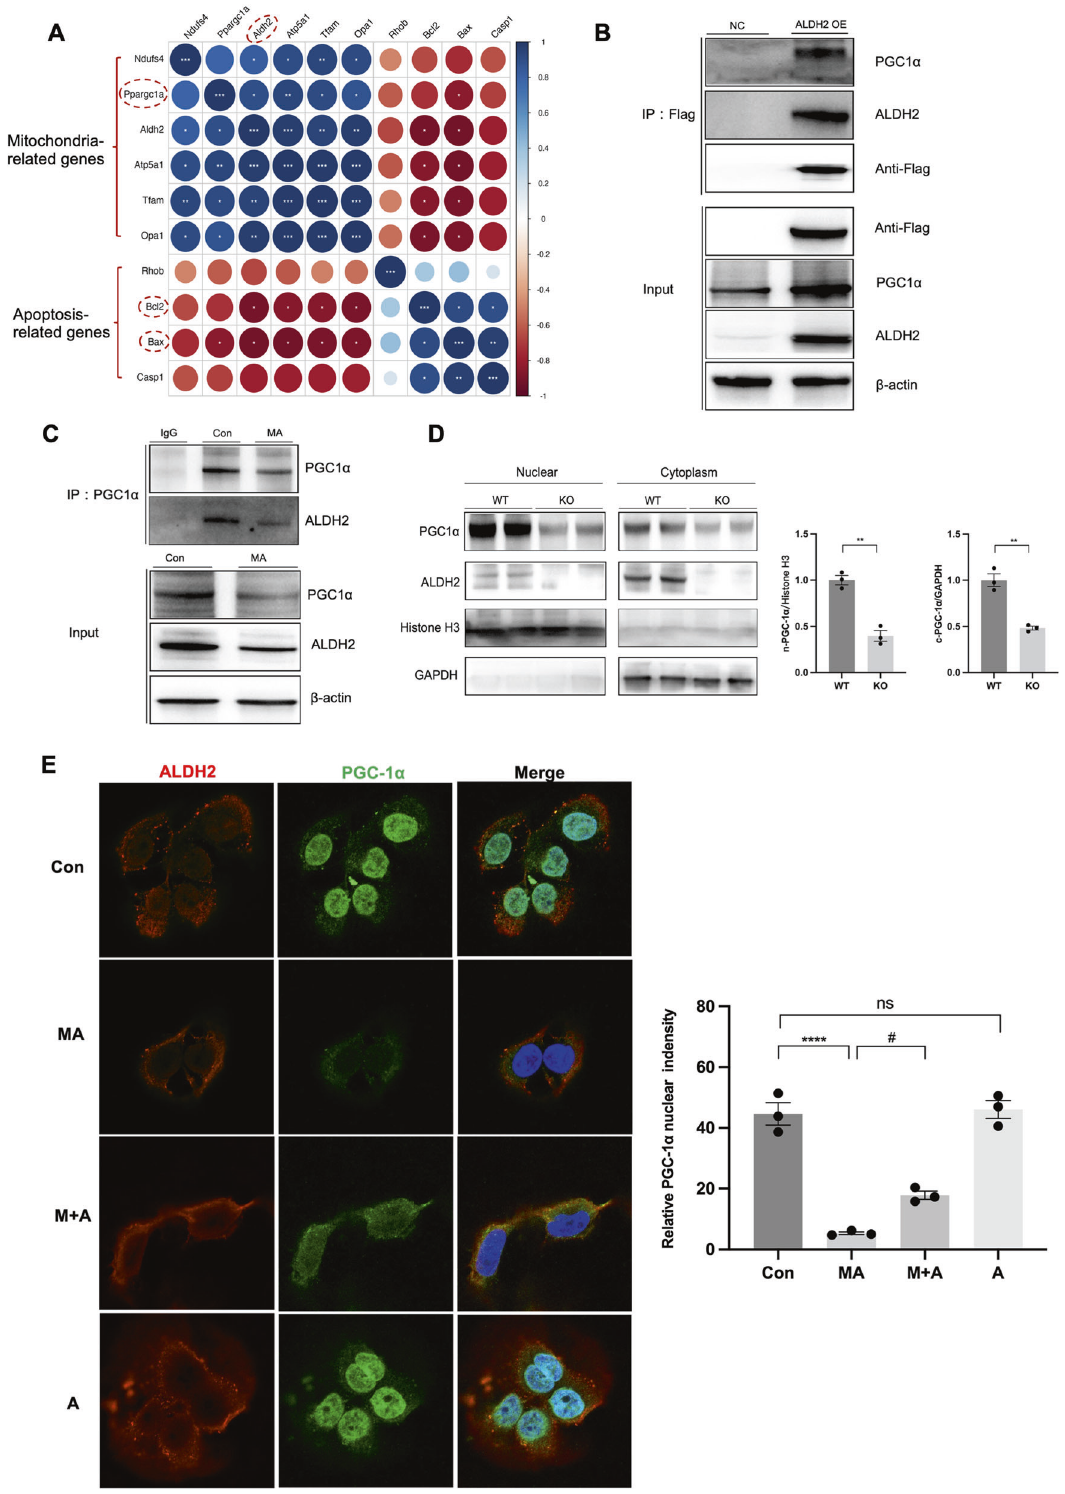
Fig. 7 ALDH2 interacted with PGC-1 α and modulated nuclear translocation of PGC-1 α . A The heap map showing the correlations of ALDH2 and the mitochondria and apoptosis-related genes. B Co-immunoprecipitation assay for the interaction of ALDH2 with PGC-1 α in ALDH2 overexpression HK-2 cells ( n = 3). Input immunoblotted is shown as a control. C Co-immunoprecipitation analysis investigating the interaction of endogenous ALDH2 with PGC-1 α in HK-2 cells with or without MAtreatment ( n = 3). Input immunoblotted is shown as a control. D ALDH2 enhanced nuclear translocation of PGC-1 α in WT kidney tissues (WT, n = 3; KO, n = 3). E Immuno fl uorescent analysis of the location of PGC-1 α and ALDH2 in HK-2 cells with or without MA andAlda-1treatment( n = 3).* P <0.05,** P <0.01,*** P <0.001,**** P <0.0001; # P <0.05.(ConControl,MAmaleic acid,M + Amaleicacid + Alda-1,AAlda- 1, n-PGC-1 α nuclear PGC-1 α , c-PGC-1 α cytoplasmic PGC-1 α , WT wild type, KO knockout, NC normal control OE, overexpression).